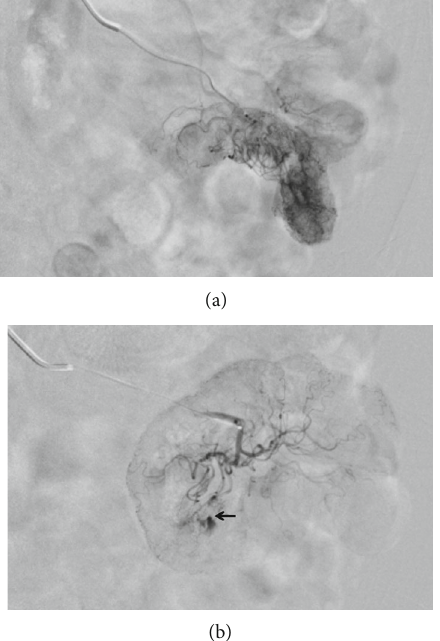
Figure 2: (a) Mesenteric angiogram showed bleeding from the jejunal branch of the superior mesenteric artery (arrow). (b) Late images of mesenteric angiogram showed collection of blood in the loop of the jejunum suggestive of active bleeding.